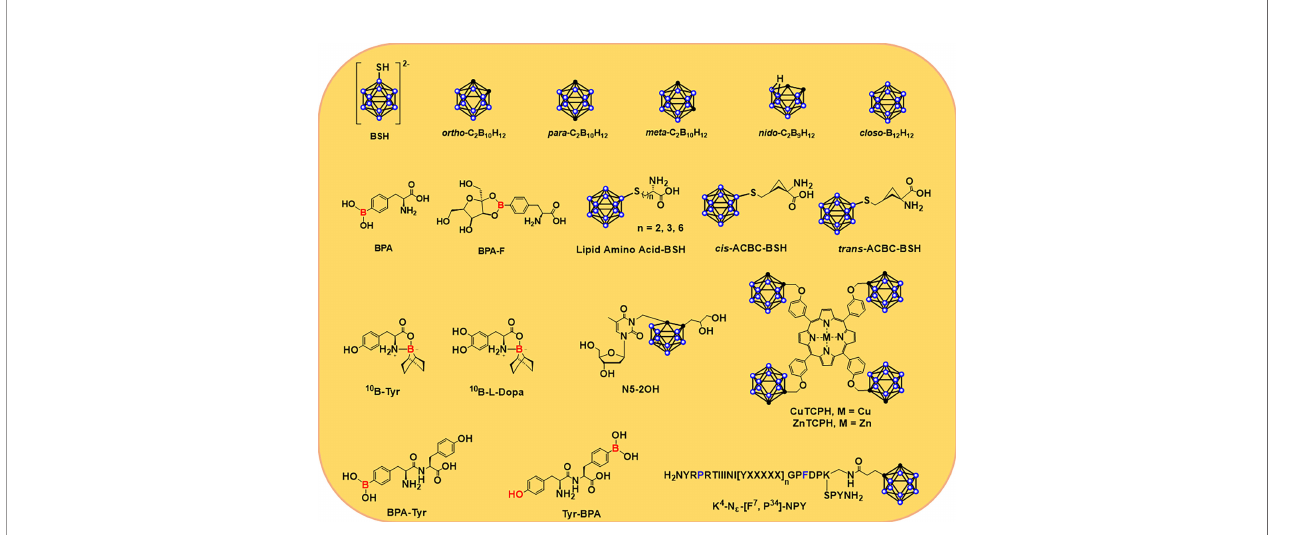
FIGURE 2 | Structures of several 10 B delivery agents, including carboranes and carboranes (39, 55, 56) that are conjugated to nucleosides (57 – 59), porphyrins (60), amino acids (11, 61, 62), and peptides